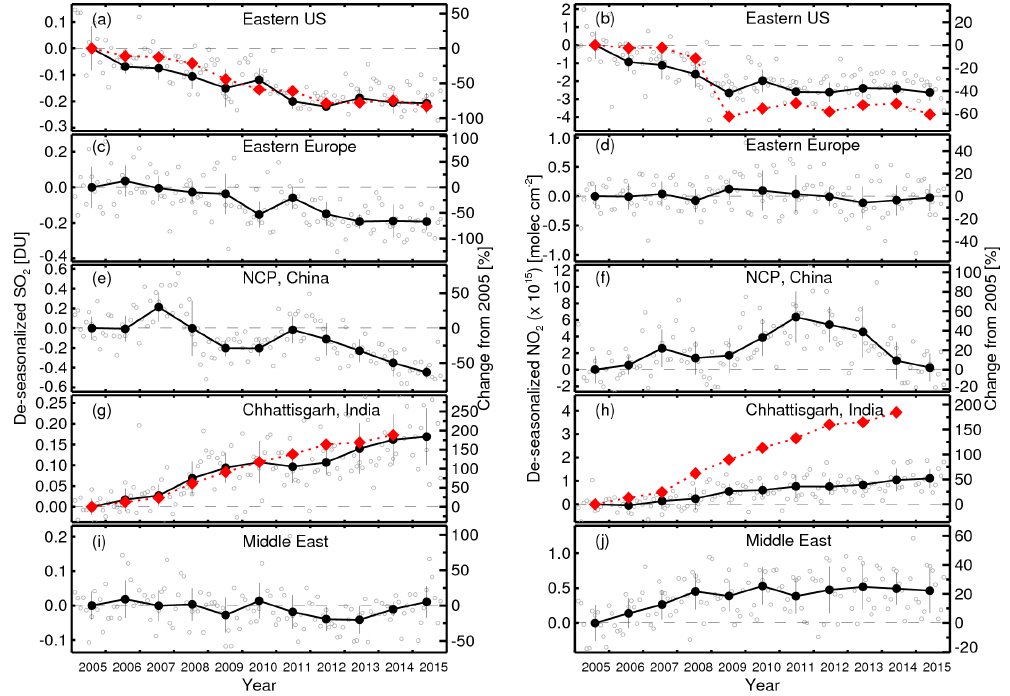
Figure 3. Relative changes (compared to 2005) in OMI PBL SO 2 columns (left) and tropospheric NO 2 columns (right) over the world’s five most polluted regions: (a) and (b) : Ohio River valley and southwestern Pennsylvania (ORV) in the eastern US (ORV – blue box in Fig. 2); (c) and (d) : the Maritsa Iztok power plants in Bulgaria (blue box in Fig. 4); (e) and (f) : North China Plain (NCP – blue box in Fig. 5); (g) and (h) : NE India (blue box in Fig. 6); (i) and (j) : the Persian Gulf (blue box in Fig. 7). Gray circles show de-seasonalized monthly columns (see details in Appendix B). Black filled circles show annual means. Vertical bars show standard deviations. Red diamonds show bottom-up emission estimates for power plants in ORV and from coal-fired power plants in NE India (Chhattisgarh and Odisha region – blue box in Fig.